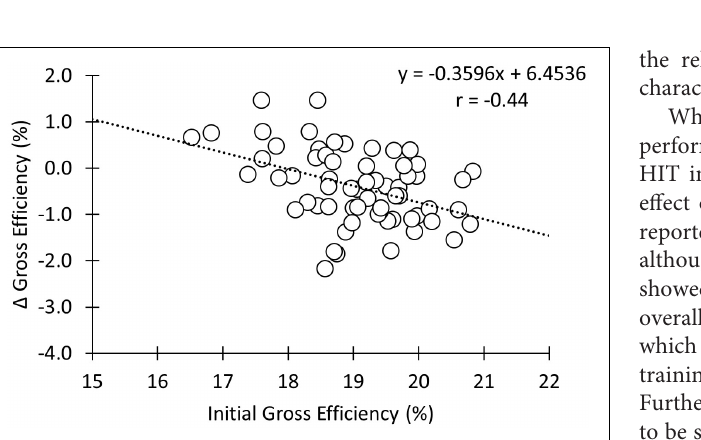
FIGURE 3 | Correlation between the change in ˙ V O 2peak during the training intervention and initial ˙ V O 2peak in absolute values (A) and normalized for body mass (B) .